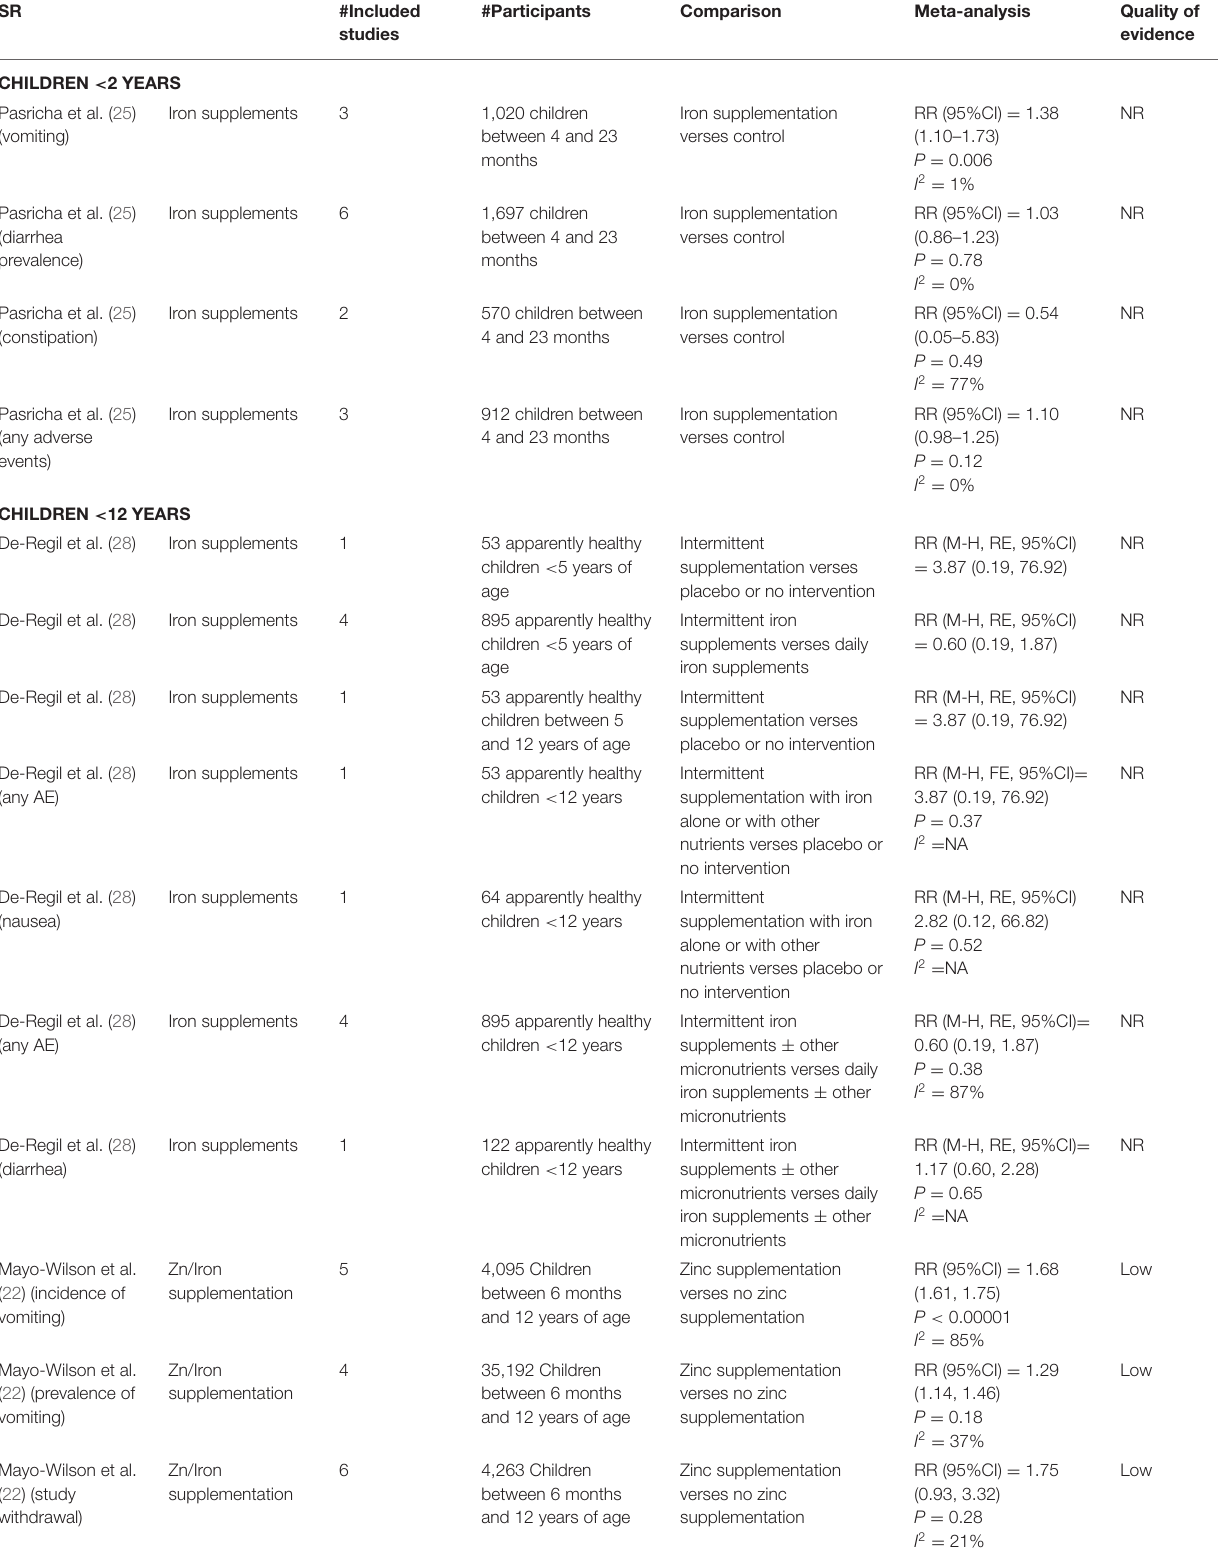
TABLE 4 | Findings for adverse events of different interventions for addressing childhood anemias in included systematic reviews. SR #Included #Participants Comparison Meta-analysis Quality of studies